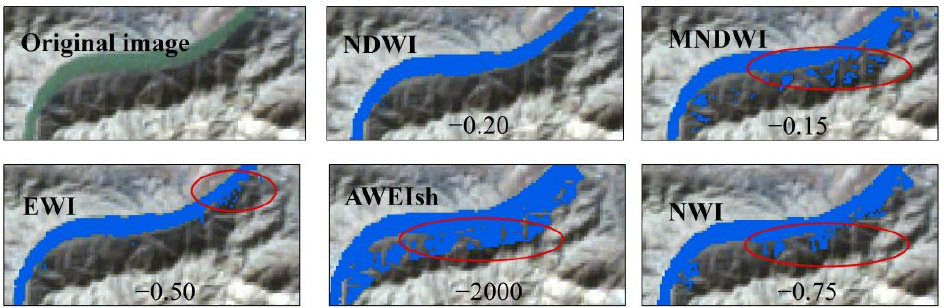
Figure 9. Results of extracting the Yellow River using the water body index, the numbers in the figure are thresholds. (The red circle is the area where the water was wrongly extracted). Table 5. Extraction accuracy of different types of water